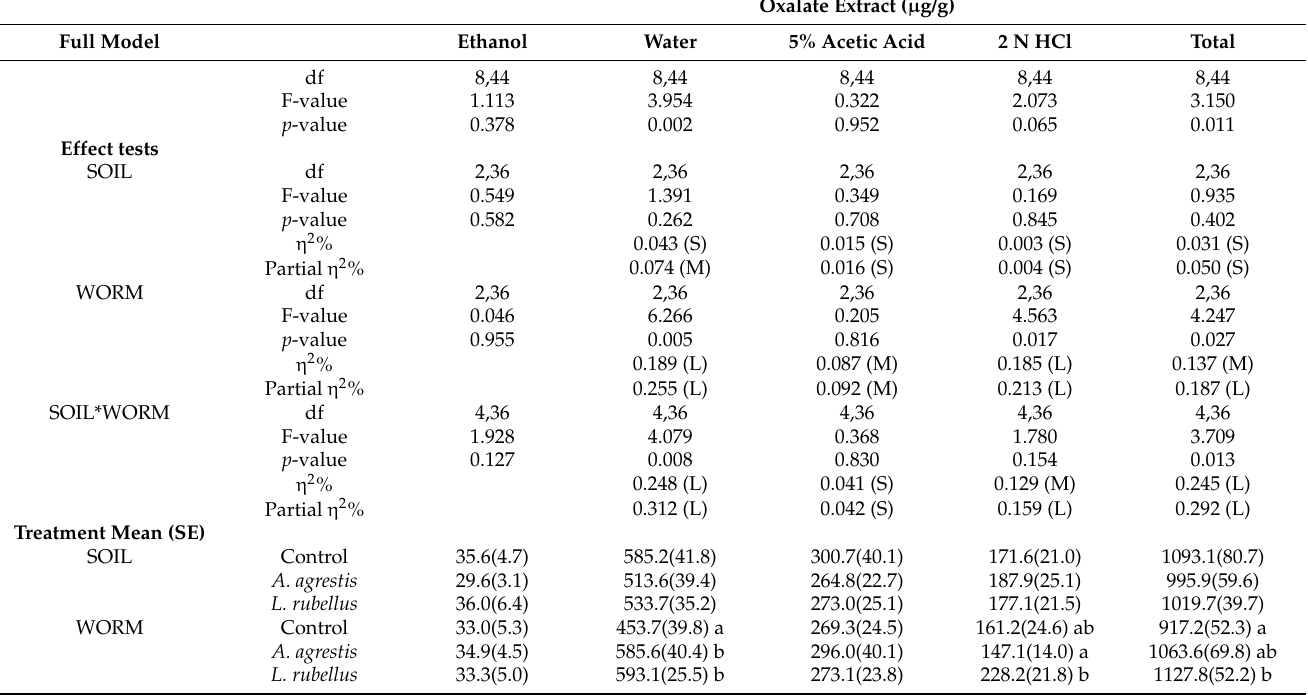
Table 1. Summary of full model and treatment effect statistical values for each extract fraction. The oxalate extracts vary left to right from low to high solubility. The mean and standard error of each treatment factor illustrate the effect where significantly different values are designated by different letters. The effect size ( η 2 ) and the partial effect size (partial η 2 %) are given as fractions of variance explained by soil, earthworm and their interaction. Effect size categories S (small), M (medium) and L (large) are also indicated for η 2